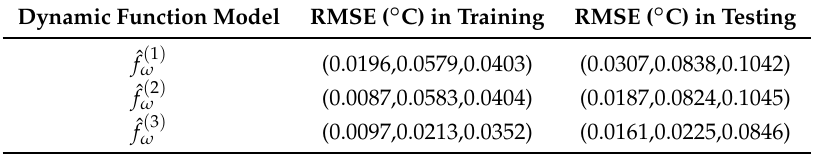
Table 3. Output response of the dynamic functions estimations in training and testing, using